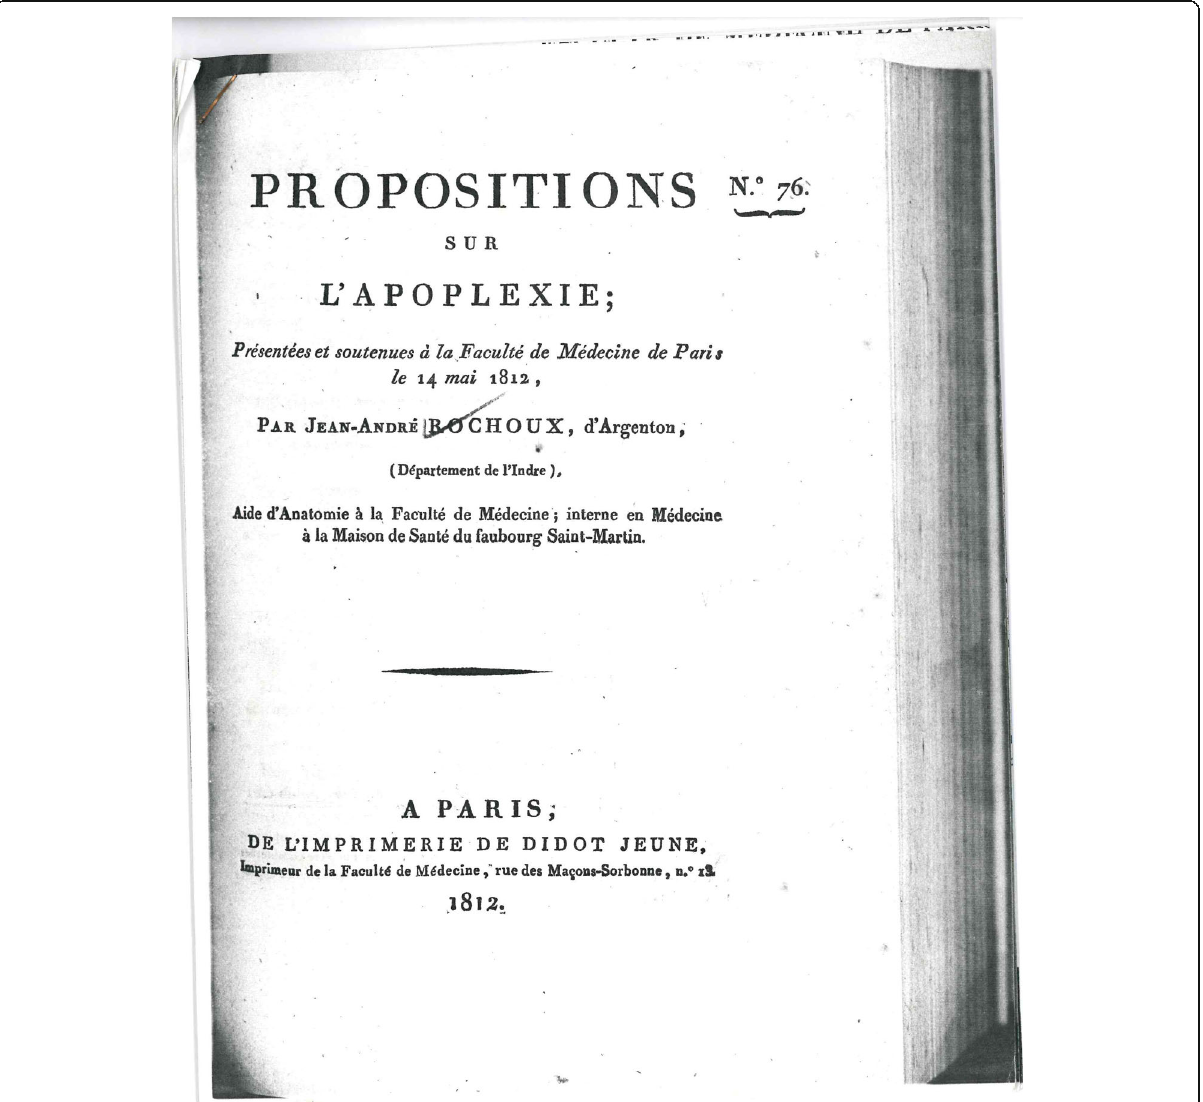
Fig. 6 Title page of Rochoux ’ 1812 dissertation on cerebral hemorrhage. With permission of the Institute for the History of Medicine and Medical Ethics, University of